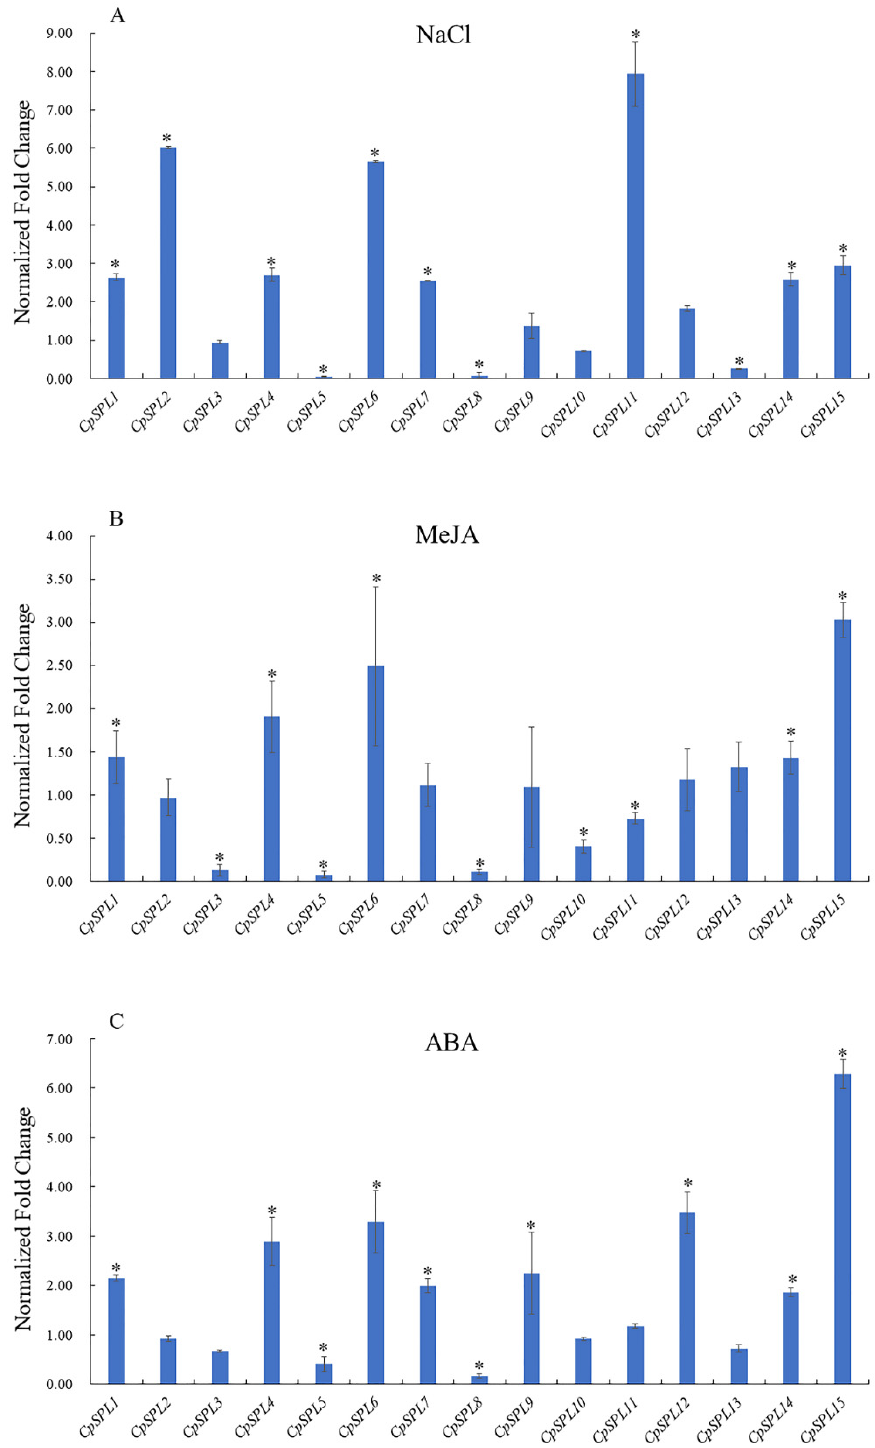
Figure 5. Relative expression levels of 15 SPL genes in Codonopsis pilosula under various treatments. ( A ) Expression changes of 15 CpSPL genes when two-week-old seedings were treated with 200 mmol NaCl. ( B ) Expression changes of 15 CpSPL genes when two-week-old seedings were treated with 200 µ mol methyl jasmonate (MeJA). ( C ) Expression changes of 15 CpSPL genes when two-week-old seedings were treated with 100 µ mol abscisic acid (ABA). Change multiples are relative to the expression level of each gene treated with ddH 2 O (set to 1). One-way ANOVA (followed by Tukey’s comparisons) tested for significant differences among means (* indicates the value is significantly different from the control at p <